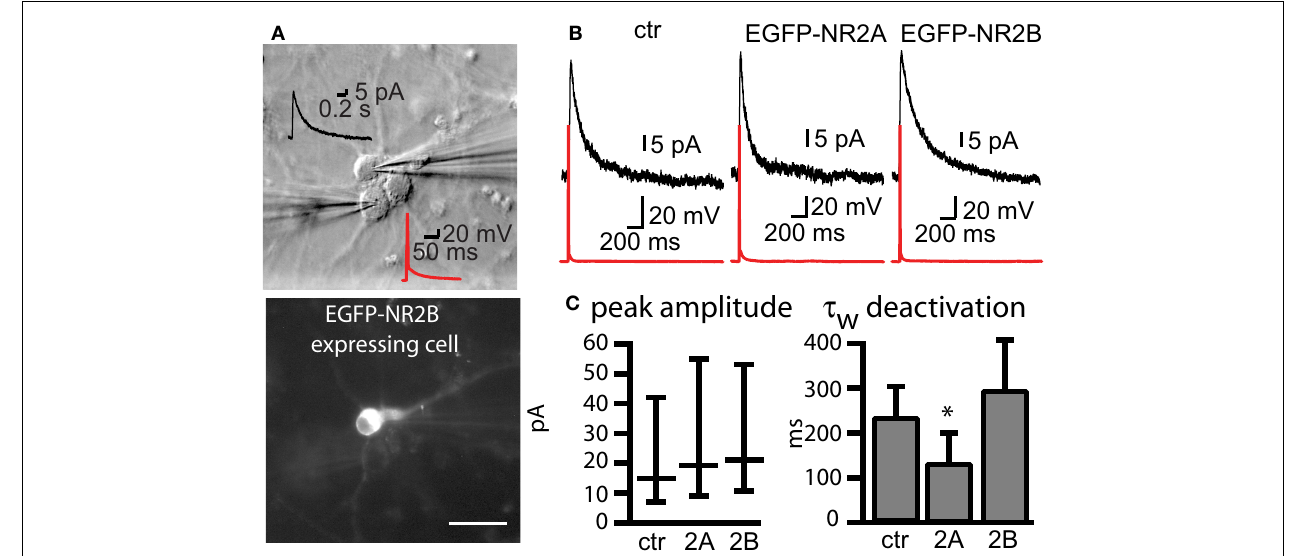
FIGURE 2 | Changes of NMDAR-mediated currents observed in cells expressing tagged receptors. (A) Infrared DIC image of three cultured hippocampal cells of which two were connected. Current injection into the lower cell evoked an AP (red), and an NMDAR-mediated EPSC (black, + 40 mV) could be recorded in the upper cell. The fl uorescence image below shows that the upper cell expressed EGFP-NR2B. Scale bar = 50 µm. (B) Example traces